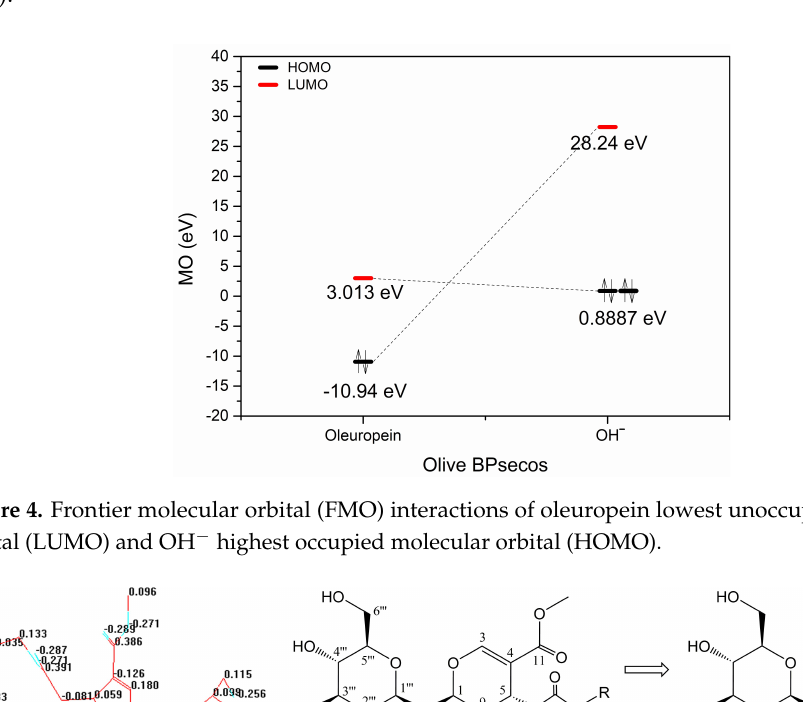
Figure 4. Frontier molecular orbital (FMO) interactions of oleuropein lowest unoccupied molecular orbital (LUMO) and OH − highest occupied molecular orbital (HOMO).